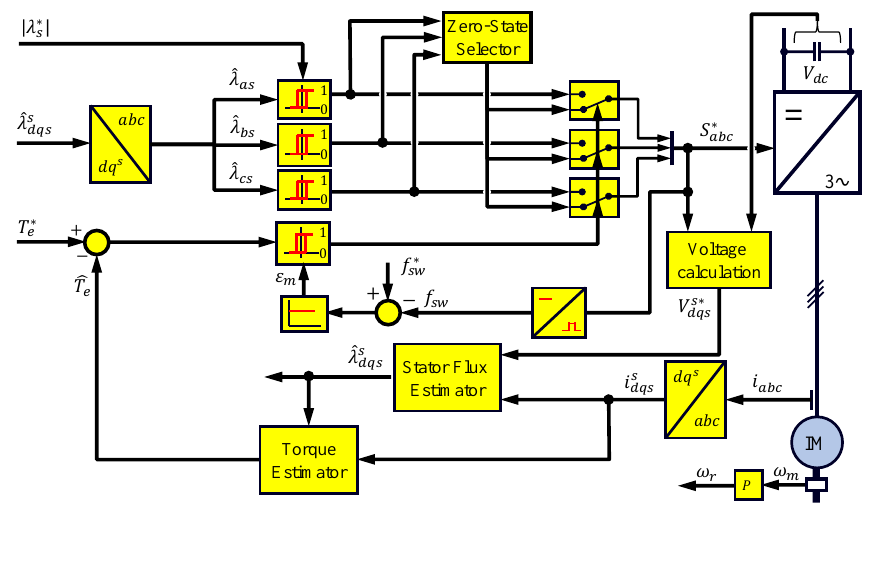
Figure 3. Direct Self-Control (DSC) scheme.